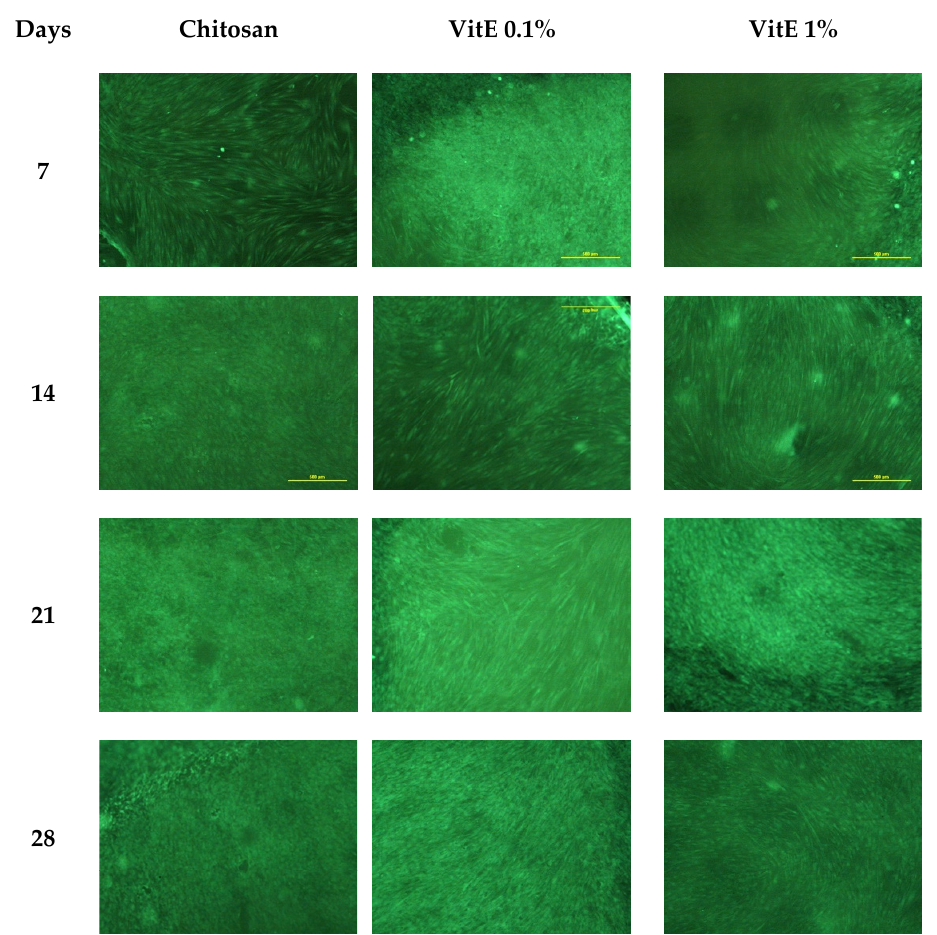
Figure 7. Fluorescent microscopy (magnification 4×) of human fibroblasts cultured with 3D chitosan scaffolds (control) on VitE 0.1 and VitE 1, respectively.